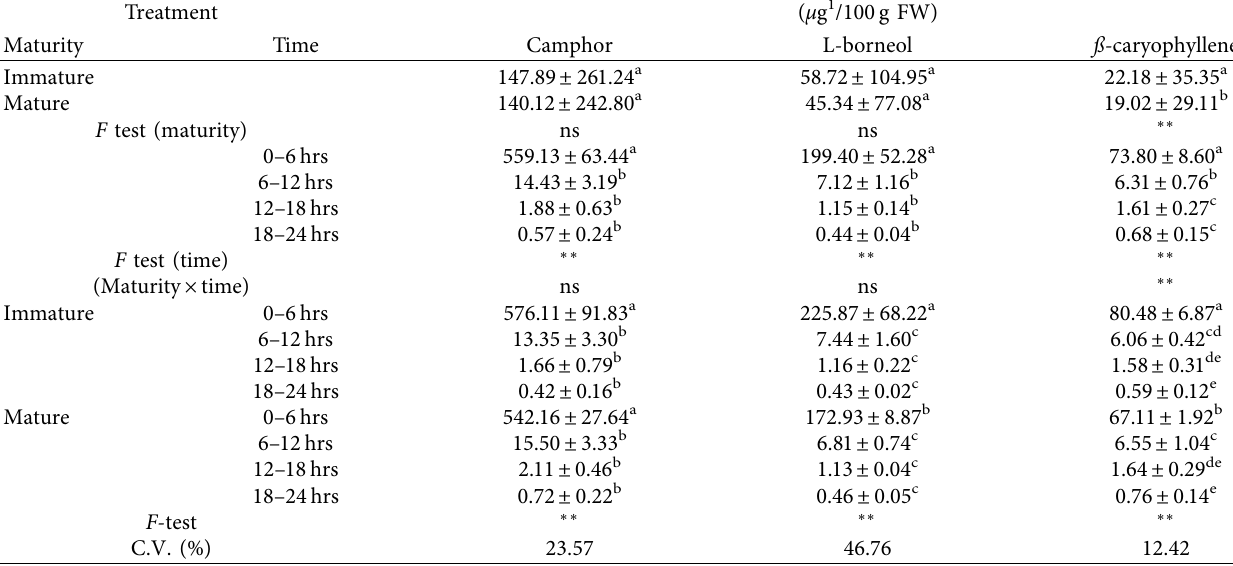
Table 4: Quantitative analysis of camphor, L-borneol, and ß -caryophyllene in essential oils from immature and mature leaves of B. balsamifera with diferent hydrodistillation